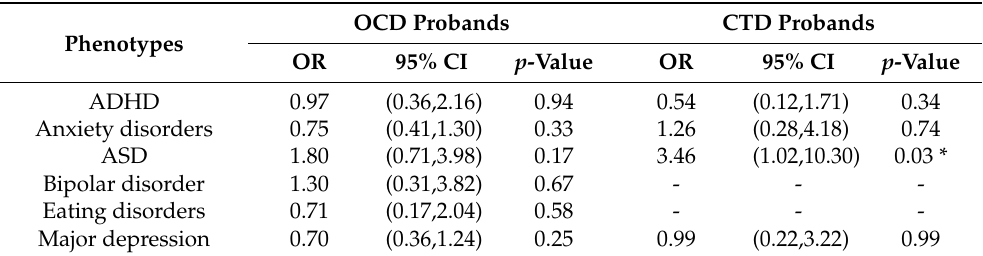
Table 6. Odds ratios for co-occurring psychiatric conditions in carriers with potentially damaging CNV.